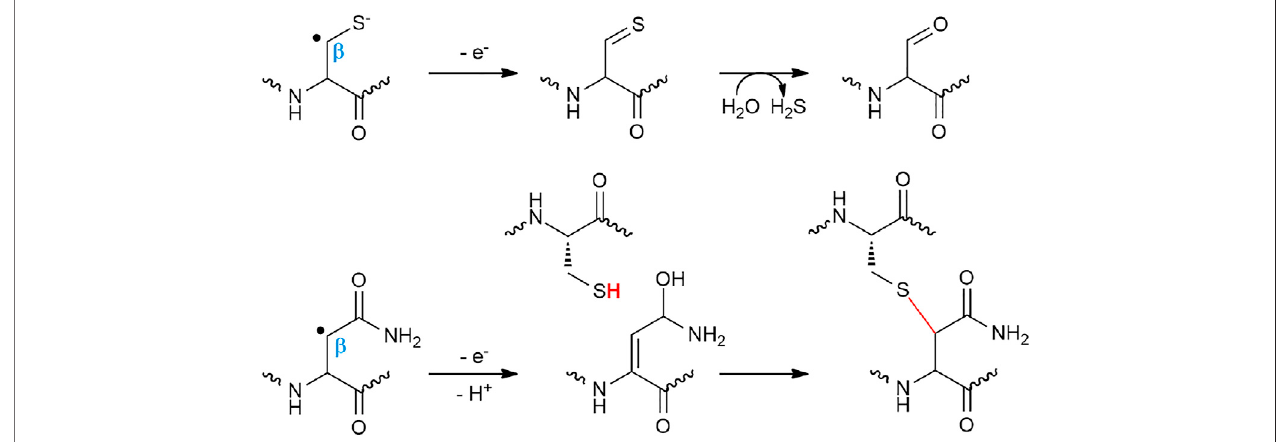
FIGURE 5 | Proposed mechanisms for anSME and NxxcB catalyzing cysteine oxidation and C β – thioether bond formation, respectively.